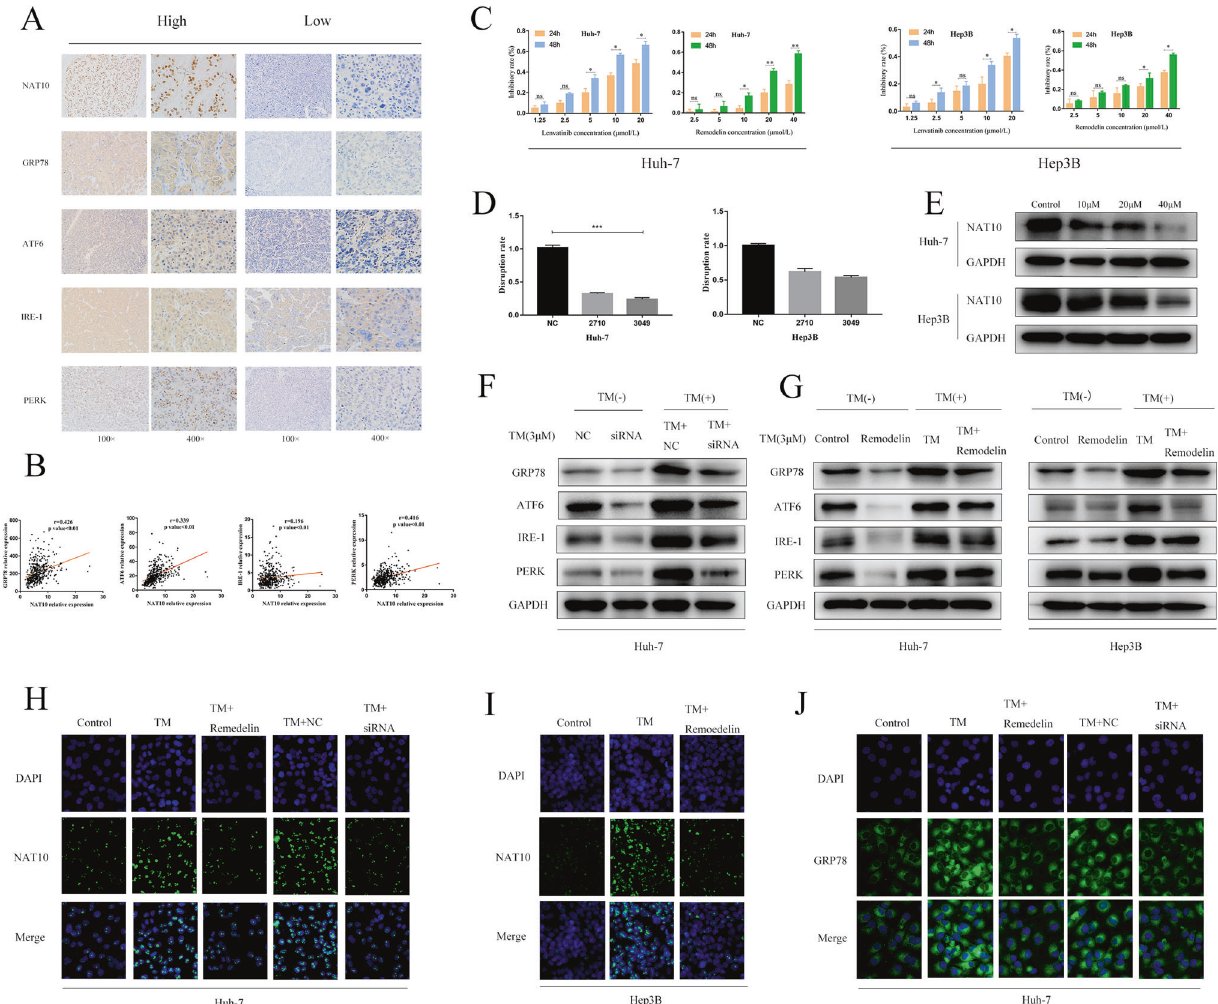
hep3B cell lines. F huh-7 cells were treated with NAT10-siRNA for 24 h. Total cell extracts were prepared and analyzed by western blotting using antibodies against GRP78, ATF6, IRE-1, PERK, and GAPDH. G huh-7 and Hep3B cells were treated with Remodelin (20 μ mmol/L) for 24